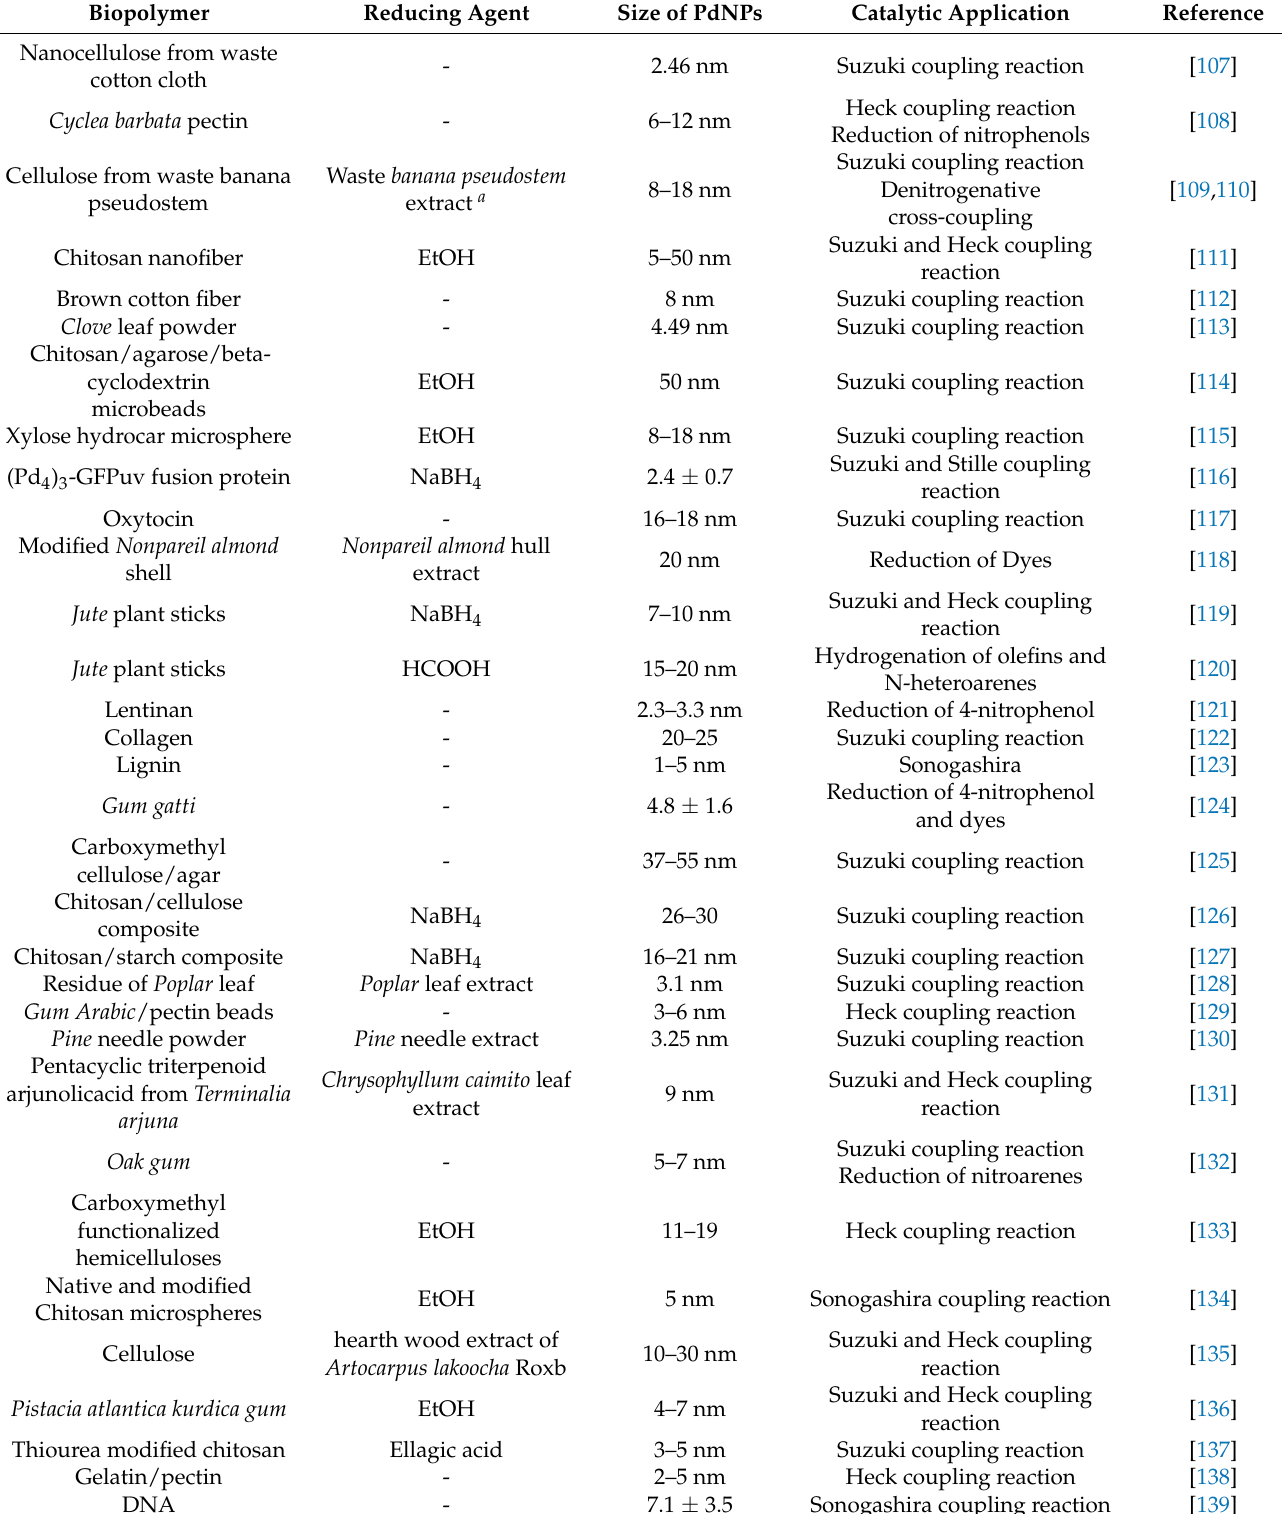
Table 3. Green synthesis of supported PdNPs on various biopolymers and their